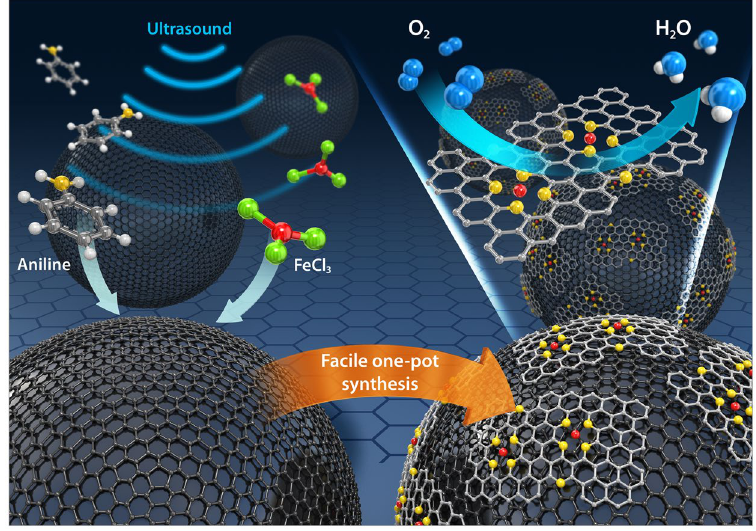
Figure 1. Conceptual diagram of our facile